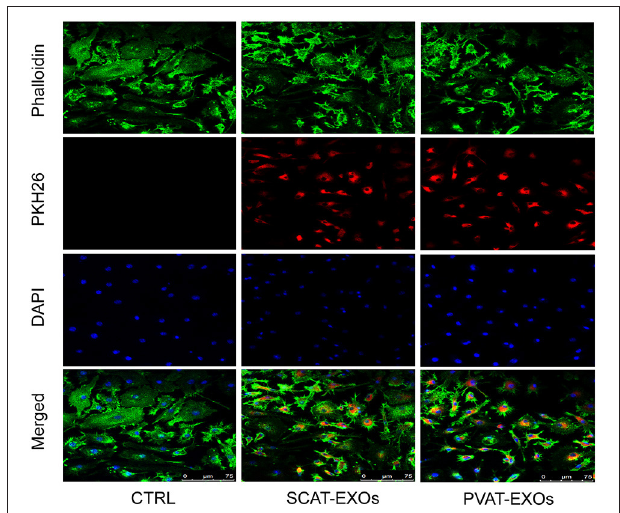
FIGURE 2 | SCAT-EXOs and PVAT-EXOs were transferred into macrophages. Exosomes were labelled with PKH26 (red) and incubated with RAW264.7 cells for 12h. The cells were then stained with phalloidin (green) and DAPI (blue). Fluorescence signals were analysed by laser confocal microscopy. Ctrl: control group. Scale bars: 75 µ